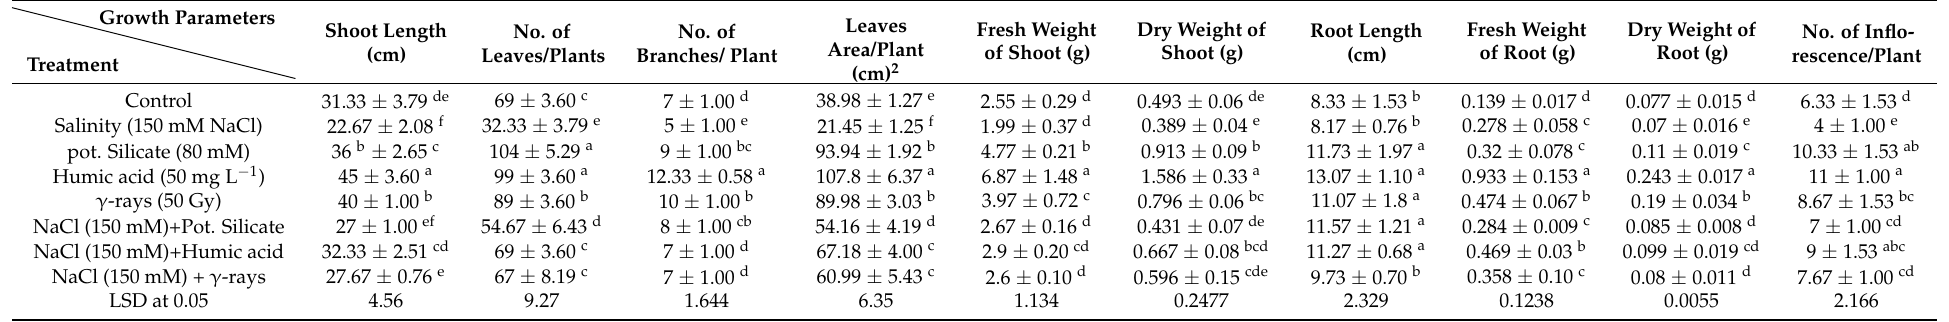
Table 3. Influence of biostimulants’ pretreatments on growth parameters of coriander plants under salinity stress at the flowering stage. Control and salinized stressed coriander samples were subjected to 80 mM pot. silicate, 50 mg L − 1 HA or soaked in water after exposure by 50 Gy γ -rays. Based on Duncan’s multiple range test, the different alphabetical letters express significant variation (defined as p <